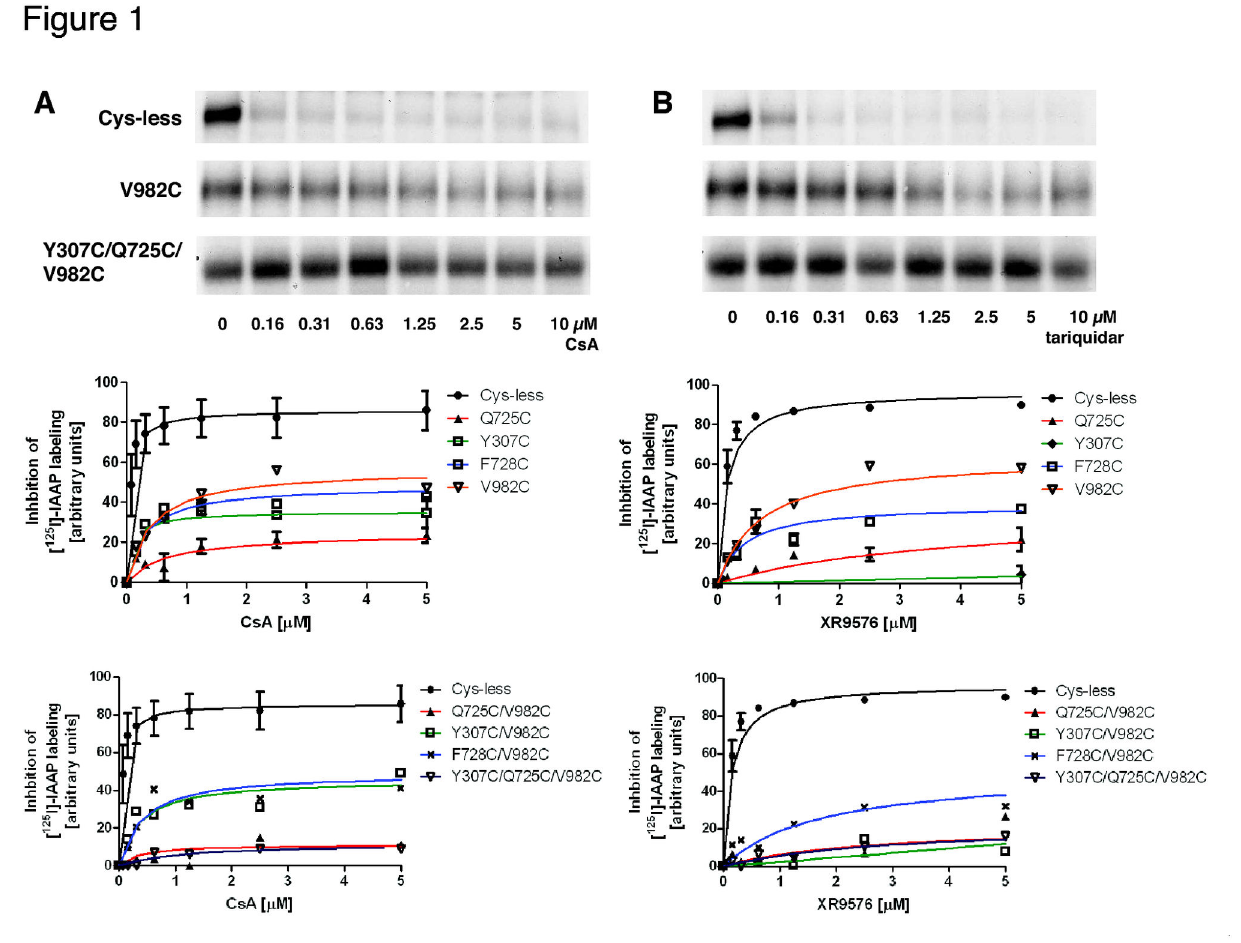
Figure 1. Inhibition of photocrosslinking of mutant Pgps with IAAP by cyclosporine A and tariquidar. Inhibition of IAAP labeling for single mutants Q725C, Y307C, F728C and V982C (upper graphs) and for double Q725C/V982C, Y307C/V982C, F728C/V982C, and triple Y307C/Q725C/V982C (lower graphs) mutants at different concentrations of (A) CsA and (B) tariquidar, are shown. Inhibition of IAAP labeling for cysless WT is included in all graphs, as a reference. Autoradiograms corresponding to cysless, V982C and Y307C/Q725C/V982C, as representative examples of complete inhibition, partial inhibition and no inhibition of IAAP-labeling, respectively, are shown at the top of the figure. Crude membranes containing Pgp (60-80 µg protein) were treated with increasing concentrations of CsA and tariquidar in 100 µL buffer containing 50 mM MES-Tris pH 6.8 for 10 min at 37°C. Then, samples were photocrosslinked with IAAP at 4°C as described in the Materials and Methods section. Mean values from at least three independent experiments are plotted and error bars depict